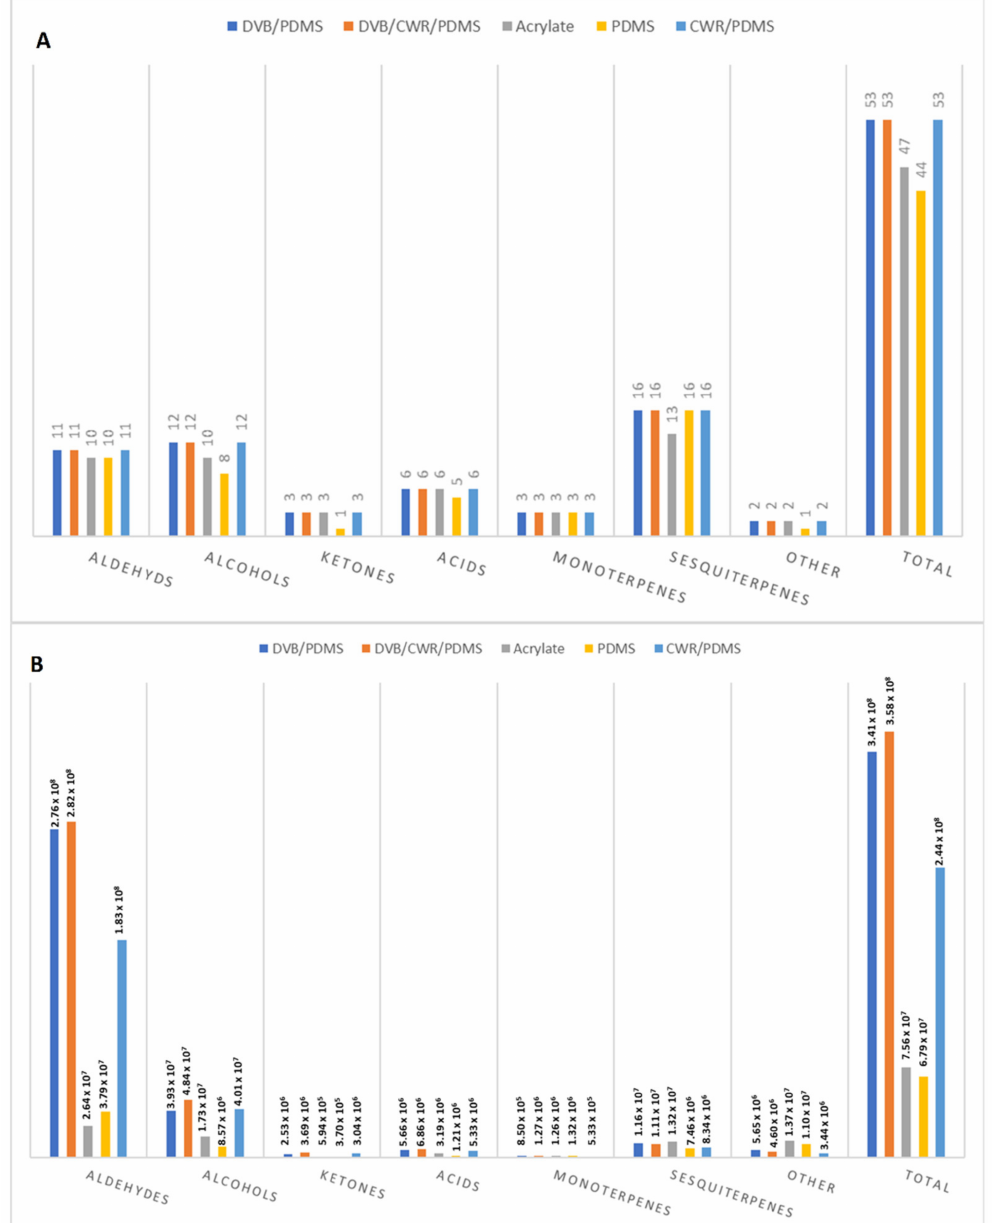
Figure 2. Number of identified volatile compounds ( A ) in skins of cv. Merlot, and the absolute peak areas ( B ) using five different SPME Arrow fibre